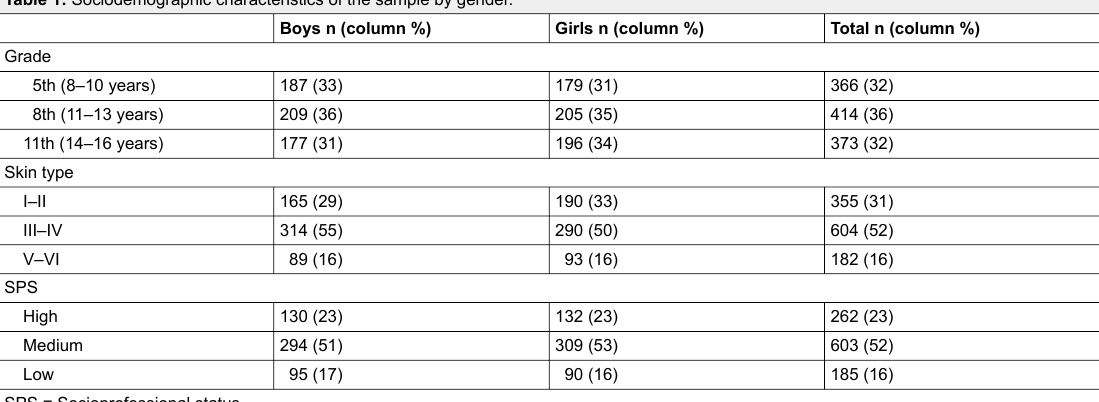
Table 1: Sociodemographic characteristics of the sample by